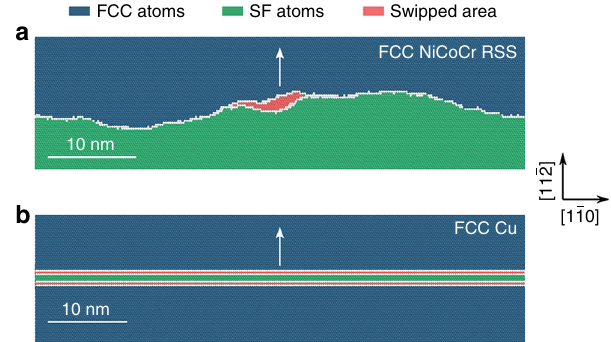
Fig. 8 Dislocation motion in FCC lattice. The molecular dynamics simulation was performed using embedded atom method (EAM) potentials, see ref. 89 for details. To observe con fi gurations associated with the intrinsic potential valley, all con fi gurations were cooled to zero temperature and unloaded to zero stress from stressed MD simulations at 300 K, and further relaxed by energy minimization. a Wavy dislocation line in FCC-NiCoCr MEA random solid solution (RSS). The leading partial (LP) dislocation moves forward in the direction marked with an arrow, one local segment at a time, while the trailing partial (TP) lags far behind (out of the picture) because the energy cost associated with erasing the stacking fault (green) is relatively high 89 . The locations of the dislocation line at two times, t 1 and t 2 , clearly reveals the nanoscale segment detrapping mechanism: the swept area (scaling with activation volume) in one stick-slip event is shown in red. This is in sharp contrast with the familiar behavior of dislocation in normal FCC, shown in b using Cu as example, where a long dislocation line (both the straight LP and TP shown in the fi gure) marches easily as a whole from one Peierls valley to the